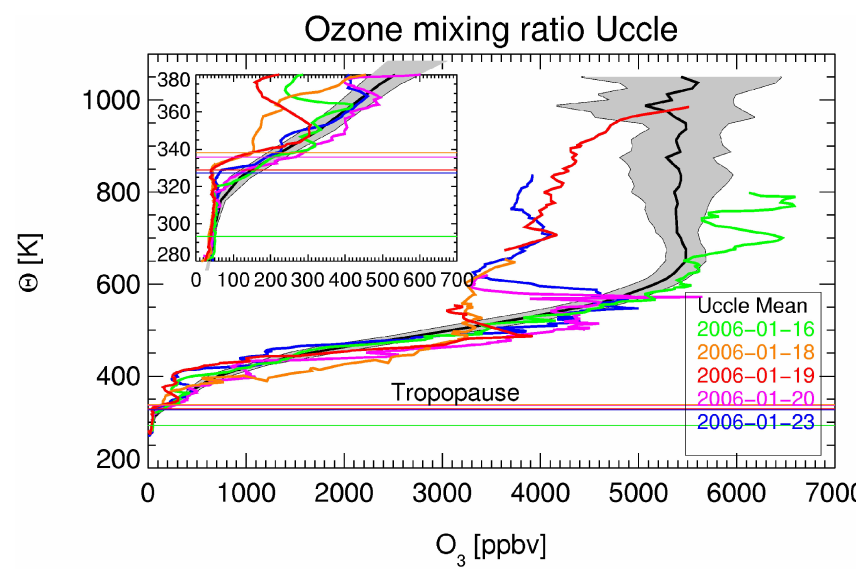
Fig. 2. Measured ozone profiles above Uccle in January 2006; the black line represents the mean of all Uccle soundings in January from 1995 to 2006 and the shaded area the 1 σ standard deviation. Tropopauses were calculated following WMO criteria. The inserted image shows a zoom into the UTLS region, with ozone in ppbv against 2 (K).